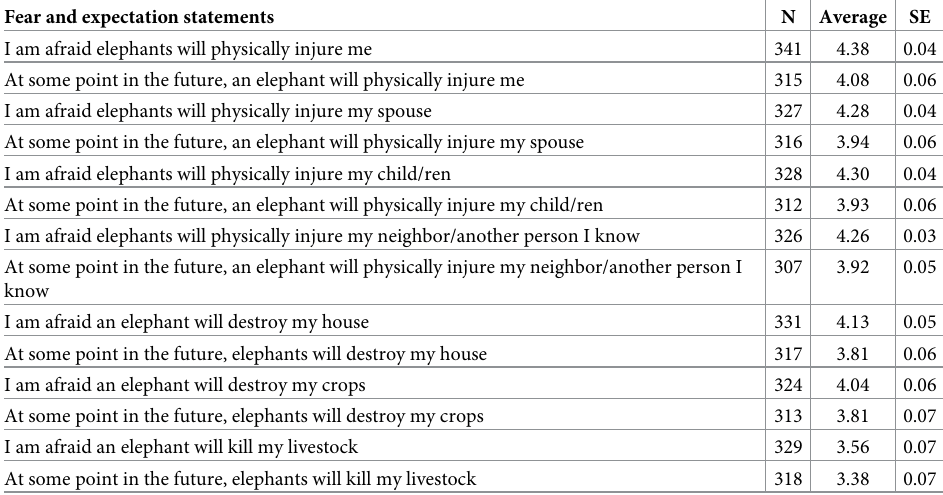
Table 3. Fear versus expectation expressed by residents in Bago-Yangon and Ayeyarwady regions of Myanmar from May 2017 to December 2018. Fear and expectation